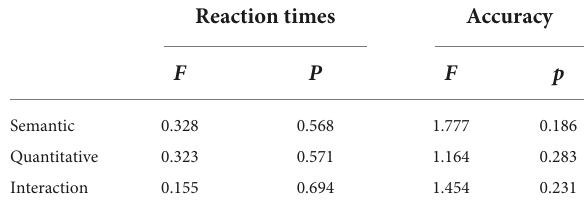
TABLE 5 Two-factor ANOVA of repeated measures of behavioral data ( N =